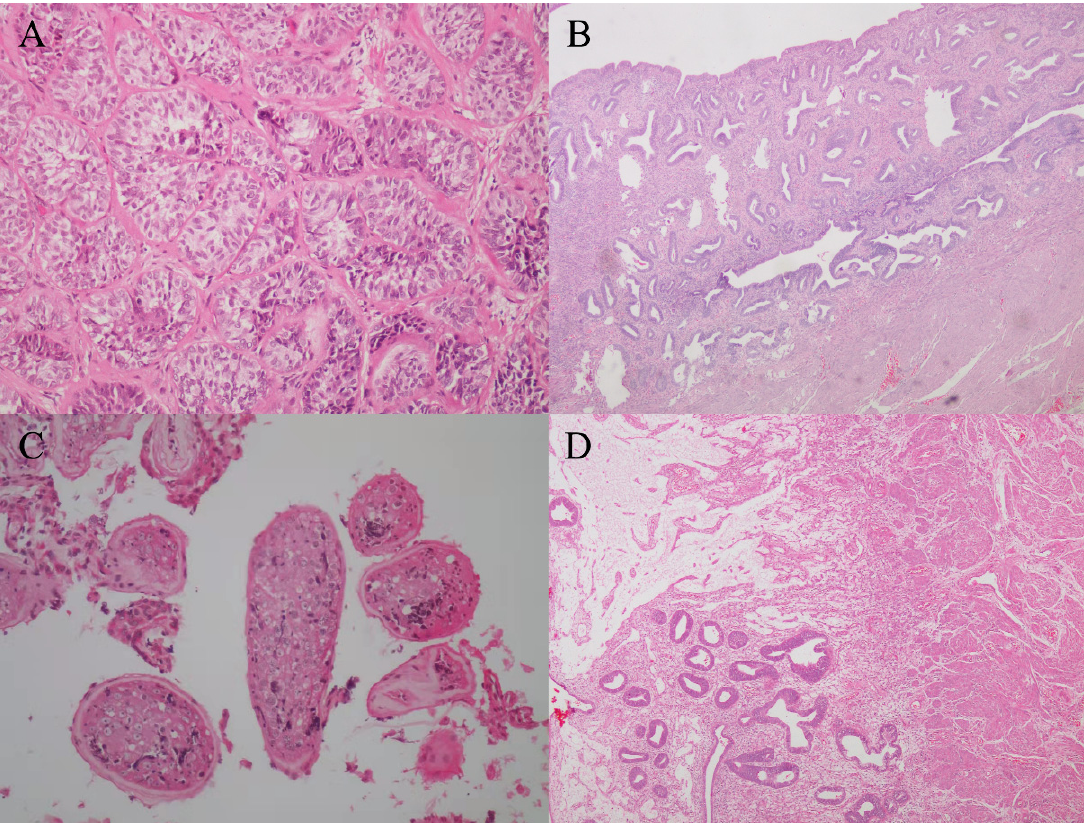
Figure 2. Histopathological staining. Histopathological analysis confirmed the organs of case 1 as testes ( A , ×200 magnification) and uteri ( B , ×40 magnification), and the organs of case 2 as testes ( C , ×200 magnification) and uteri ( D , ×40 magnification).